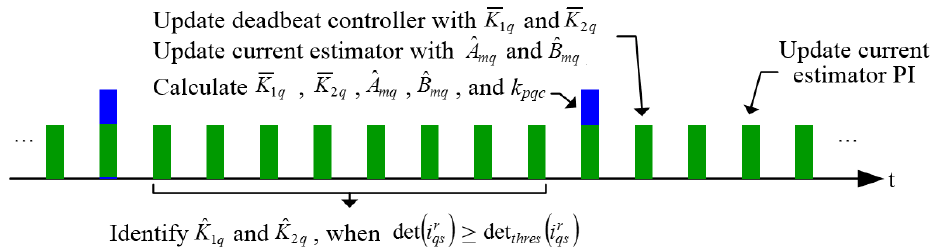
Figure 16. Time sequence of the gain identification, calculation and updating.